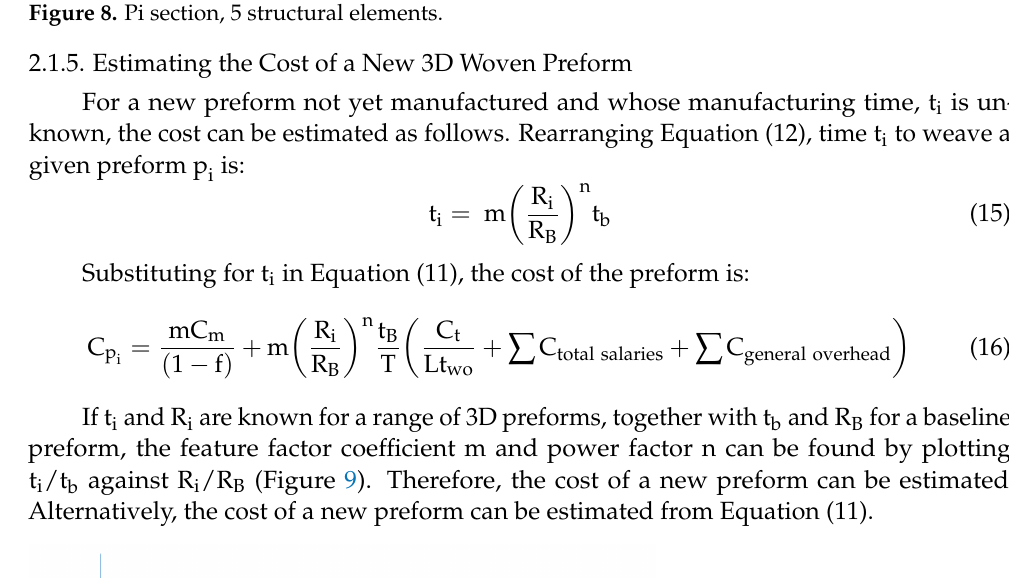
Figure 8. Pi section, 5 structural elements.